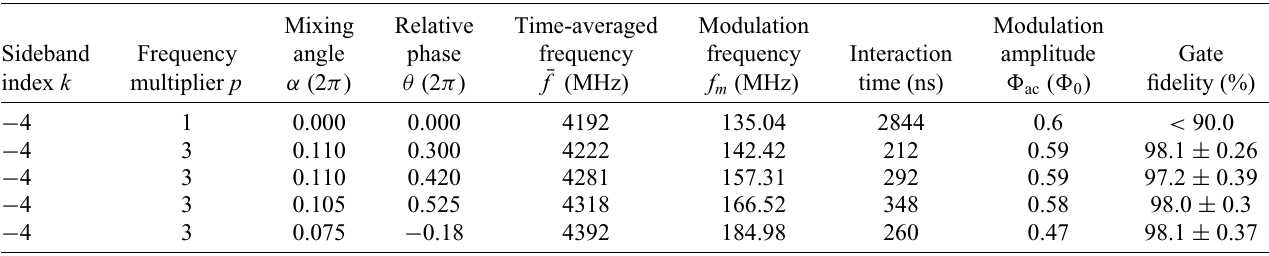
TABLE II. Information about the CZ 02 operating points and gates presented in Sec. III and Fig. 7, listed in order of qubit 1’s of these operating points represent dynamical sweet spots with first-order protection against 1 / f flux noise. An exact monochromatic fidelity is not provided due to low signal to noise in the interleaved randomized benchmarking procedure, which is ill suited to measuring such low